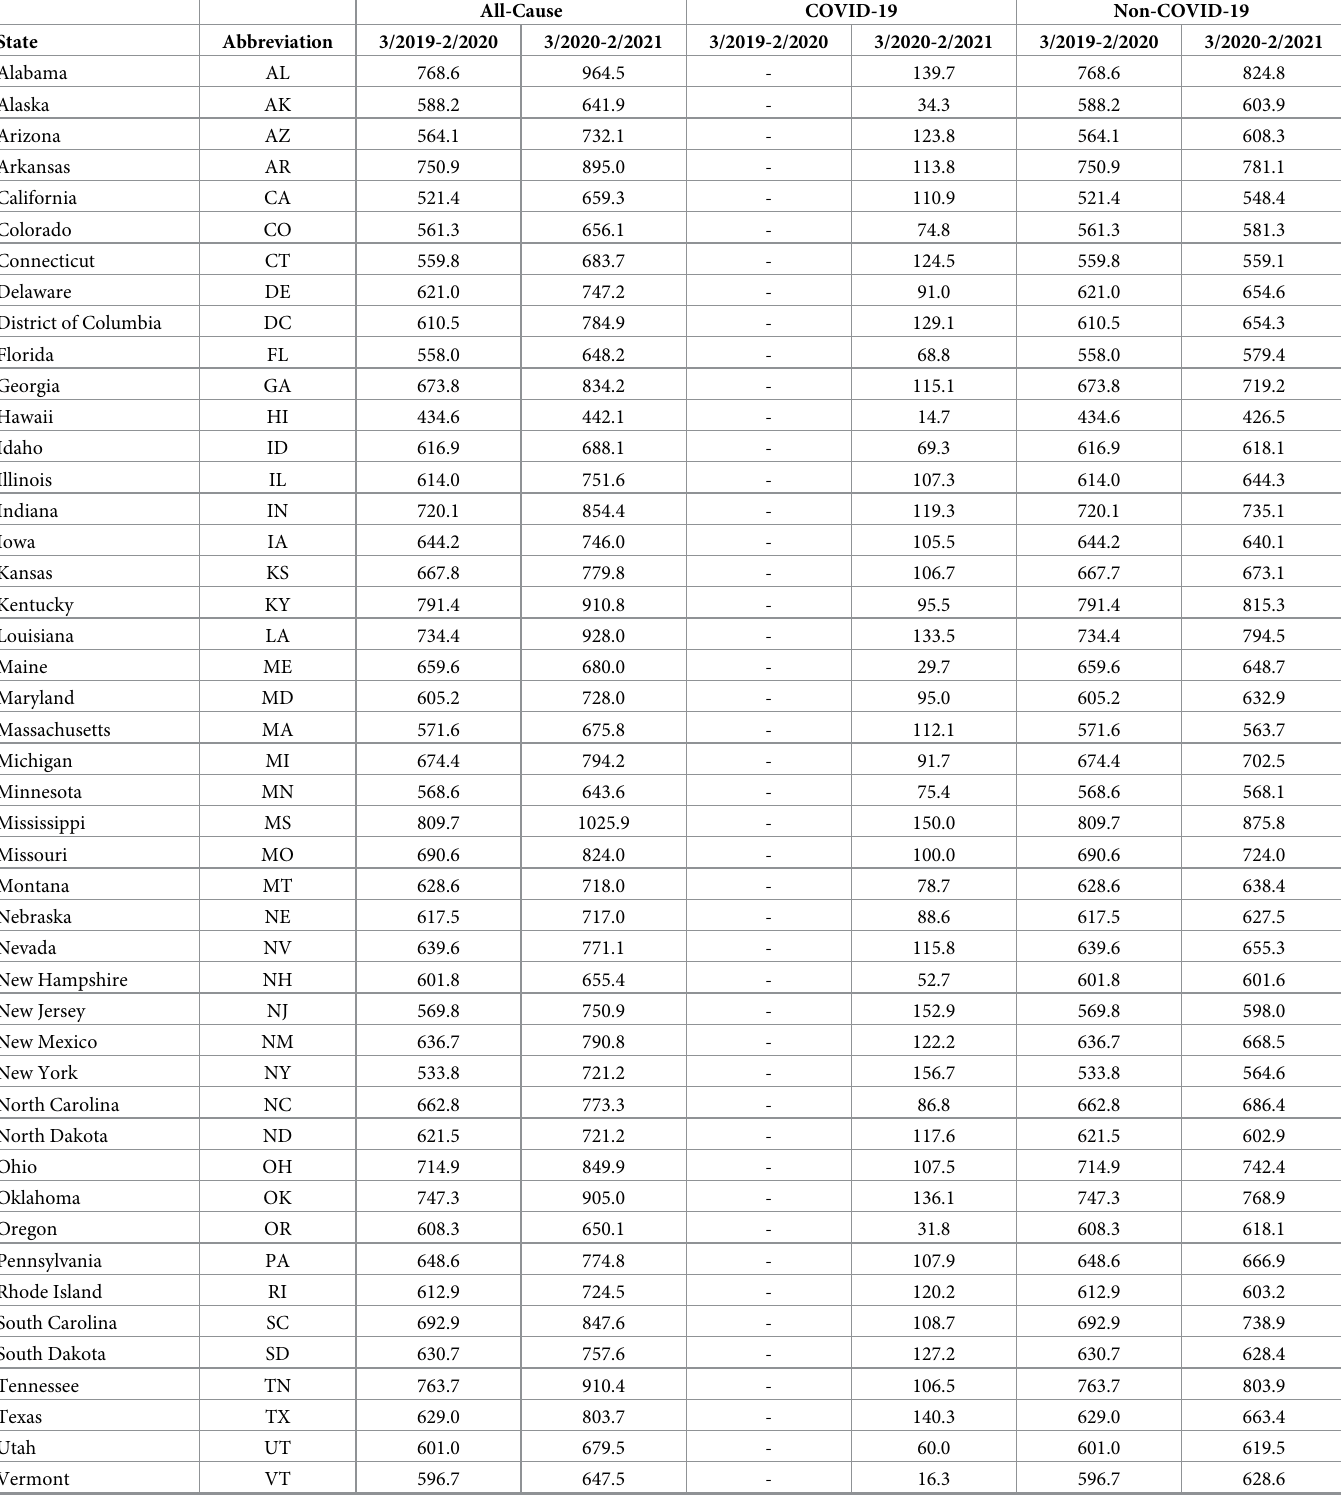
Table 2. All-cause, COVID-19, and non-COVID-19 ASDR for ages 25+ by state and time